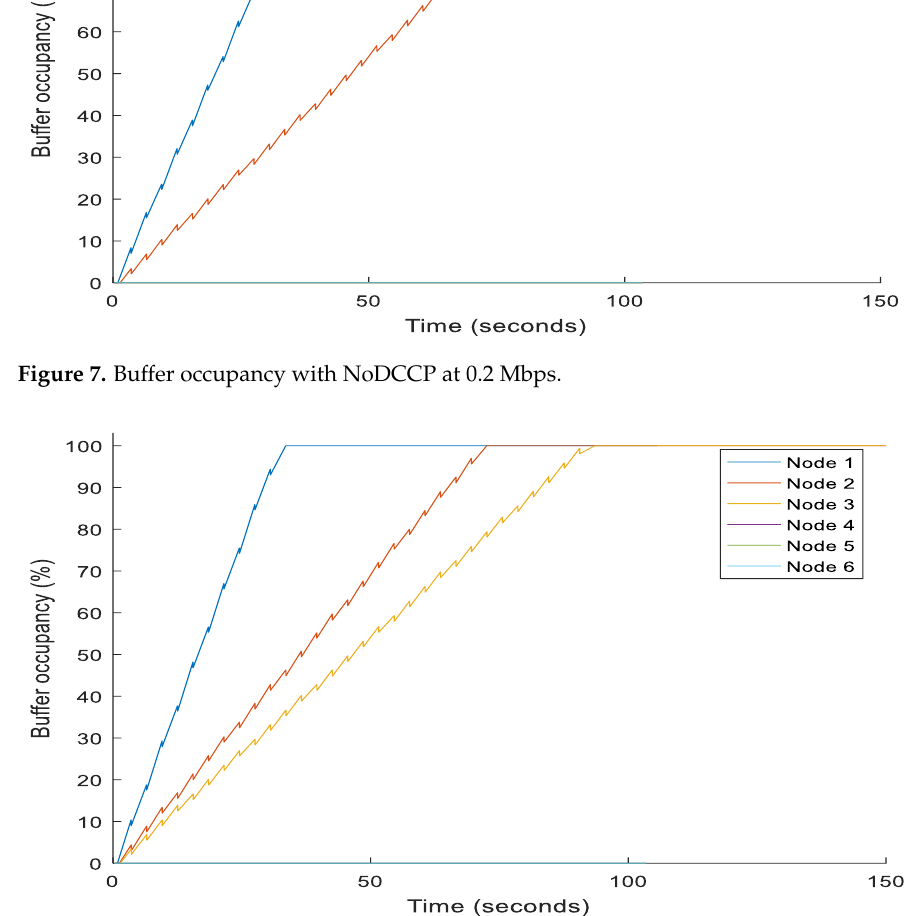
Figure 8. Buffer occupancy with NoDCCP at 0.3 Mbps.